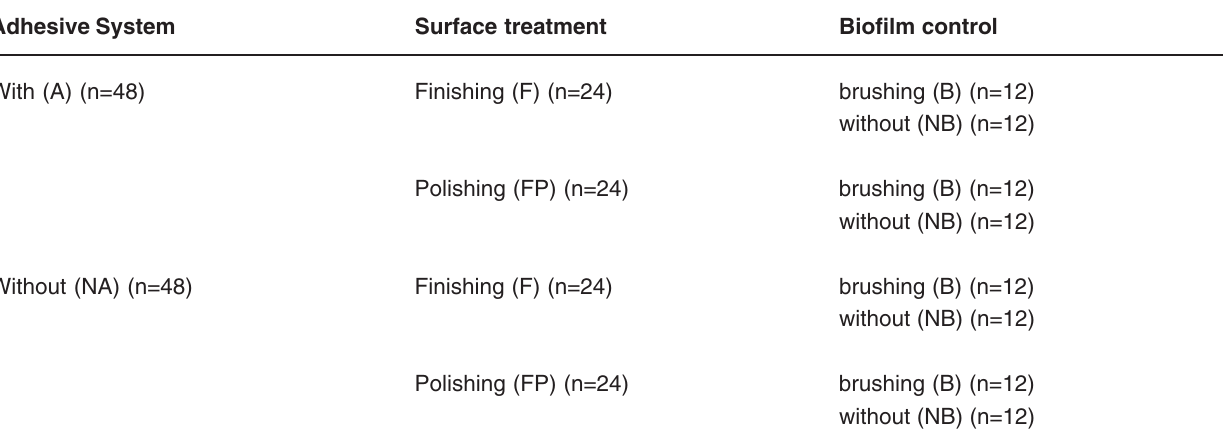
TABLE 1- Distribution of the enamel blocks according to adhesive system, surface treatment and biofilm